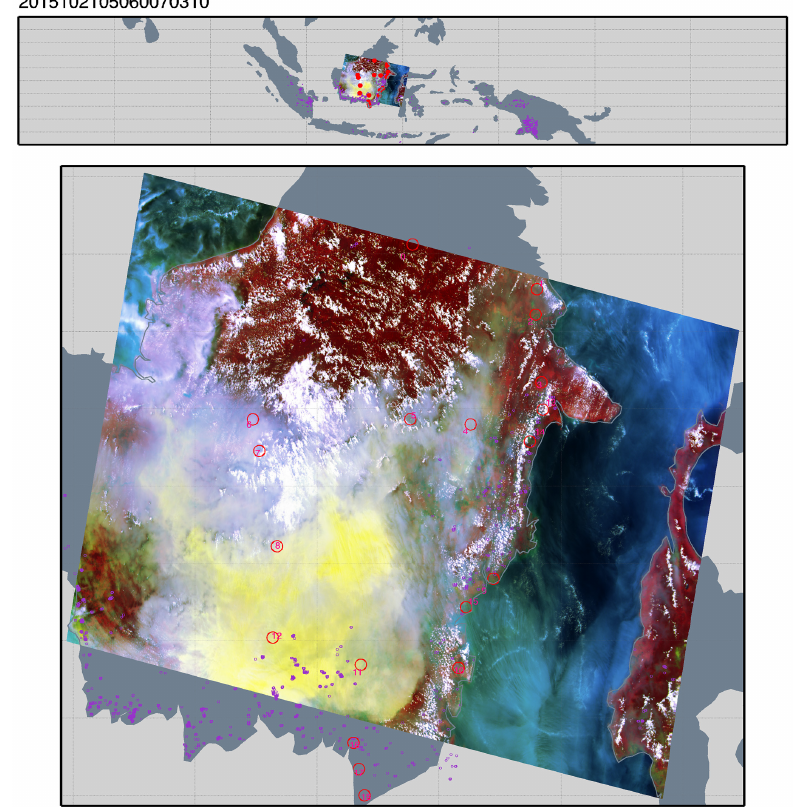
Figure 4. False-colour image (RGB indicates CAI band 3, 2, 1) derived from data taken by the GOSAT CAI, collected when the GOSAT satellite passed over the island of Borneo on 21 October 2015 (around 13:00LT, 05:00UTC), a period when extreme fires were burning across much of Central Kalimantan. GOSAT TANSO-FTS sounding locations are identified by the numbered large red circles, with the MODIS active fire detections identified by the small purple circles.